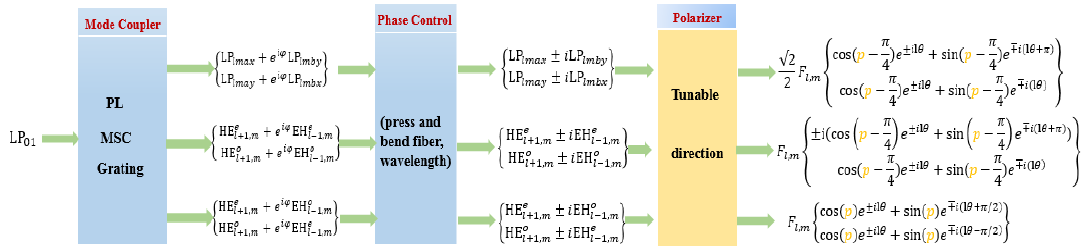
Figure 11. The flow chart of tunable OAM generation by adjusting the polarization direction.